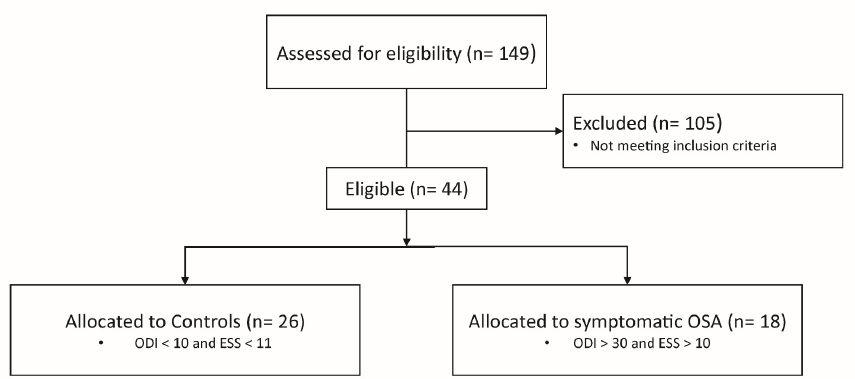
Figure 1. Study Flowchart .